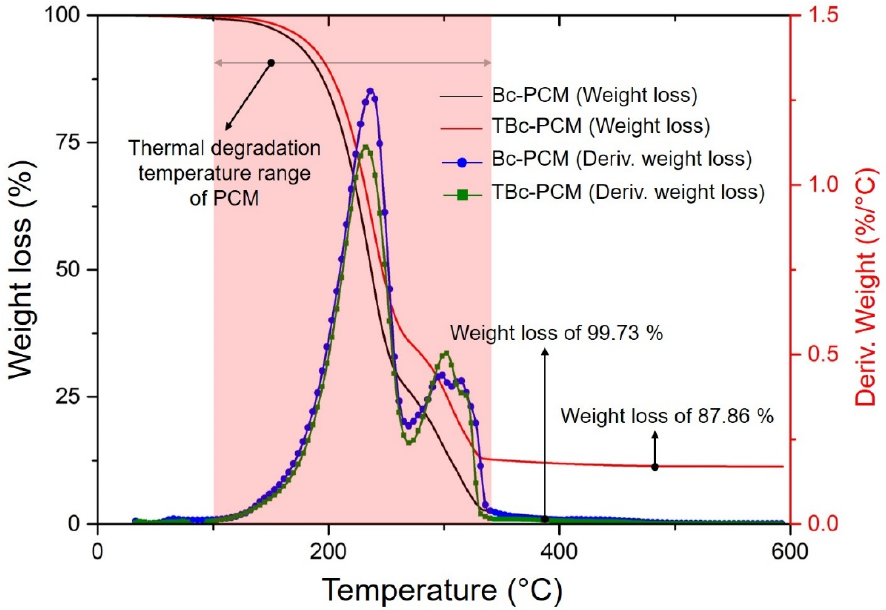
Figure 5. Thermal durability analysis of Bc-PCM and TBc-PCM.